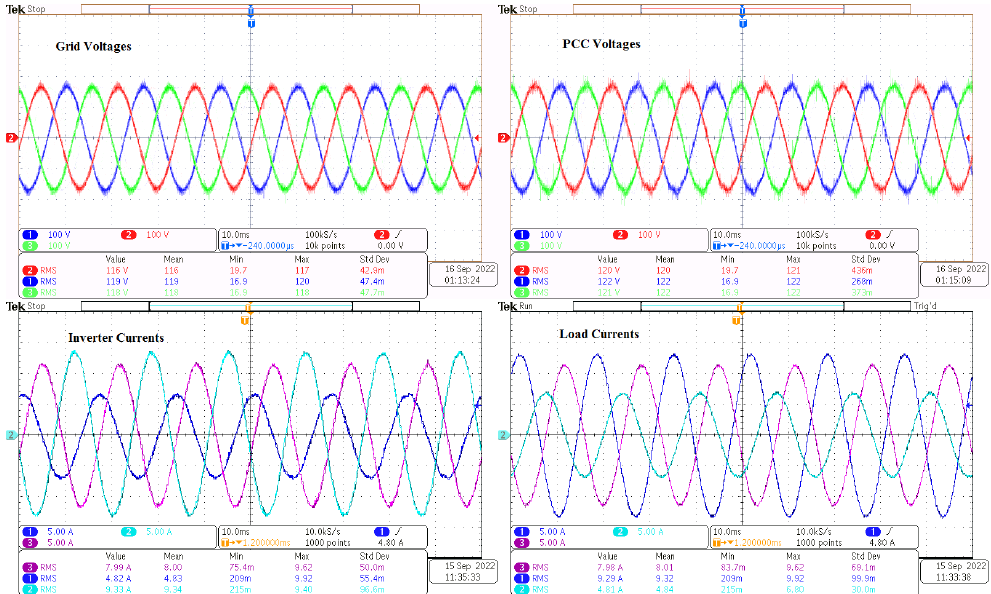
Figure 17. Hardware results using a Tektronix MDO3024 oscilloscope for real power = 0 W and reactive power = 0 var under balanced grid inductance.